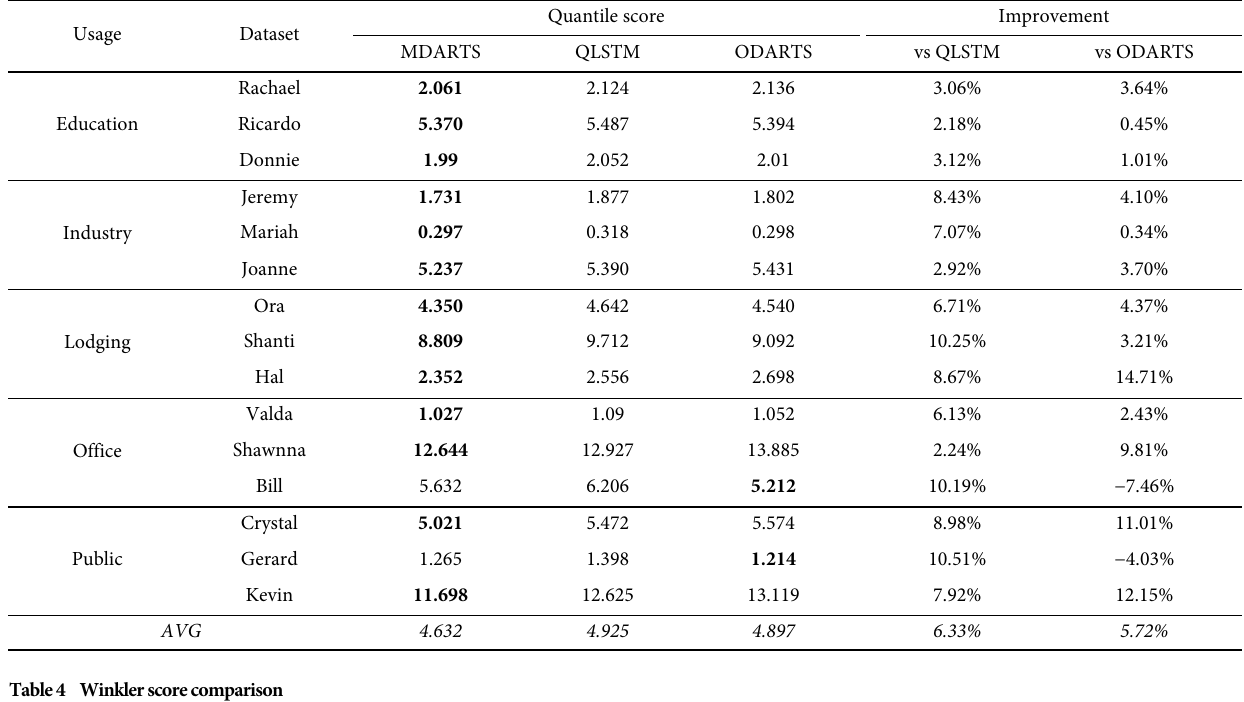
Table 4 Winkler score comparison